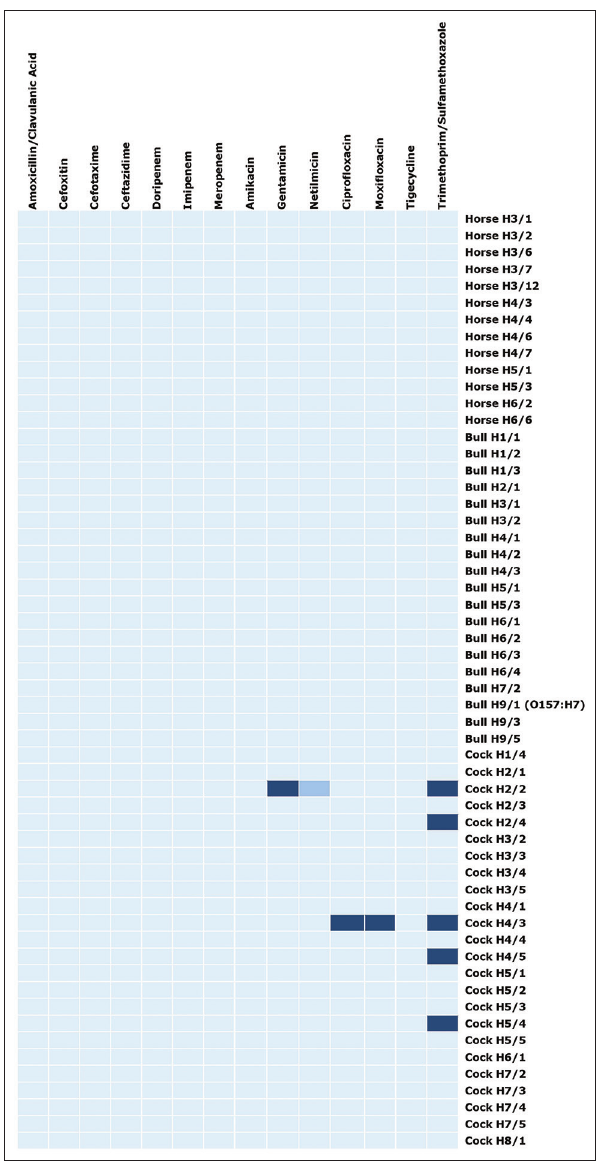
Figure-2: Heat map of antimicrobial susceptibility patterns of 55 isolates of Escherichia coli and one isolate of E. coli O157:H7 from sport animals. Each row represented each